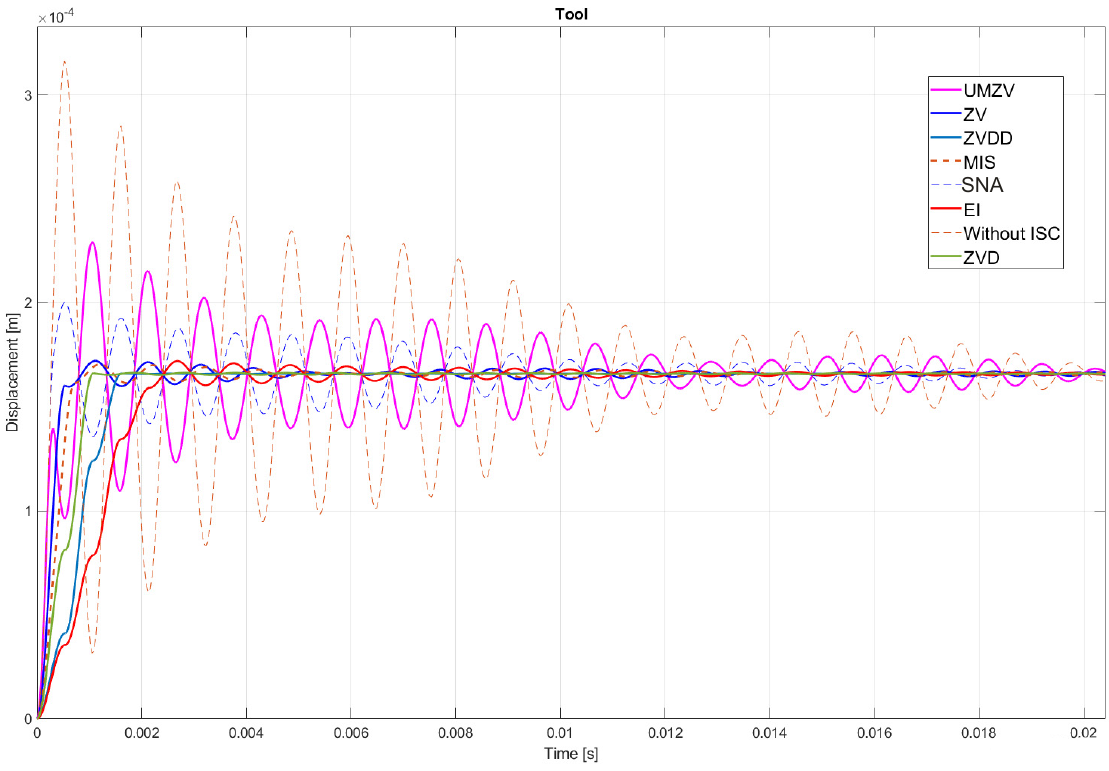
Figure 13. ISC signal of UMZV, ZV, ZVD, ZVDD, MIS, SNA and EI algorithm during rough machining.